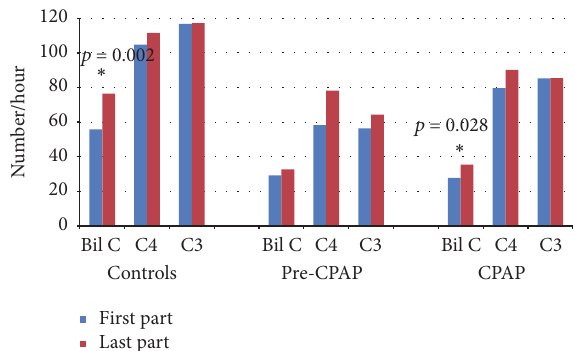
Figure 1: Central spindle densities in the first and the last part of the NREM sleep in the study groups. The statistically significant differences are marked with an asterisk and denoted with the 𝑝 values.